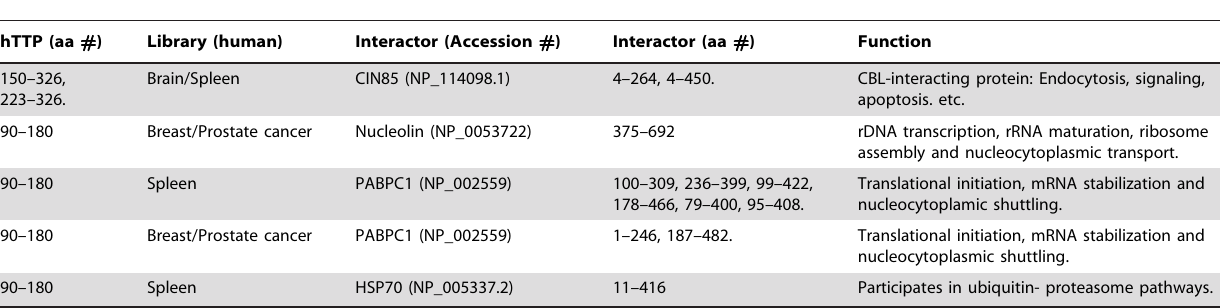
Table 1. Potential protein interactors with